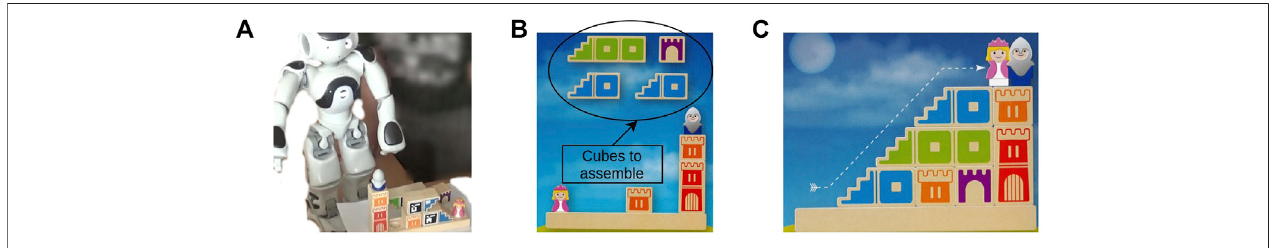
FIGURE 1 | Agents solving the Camelot Jr. game. (A) Agents play sequentially: the human starts to play, and then it is the robot ’ s turn. (B) This puzzle starts with four cubes to assemble. (C) The cubes are correctly assembled, and the puzzle is solved (i.e., a path composed by cubes is created between both fi gurines).